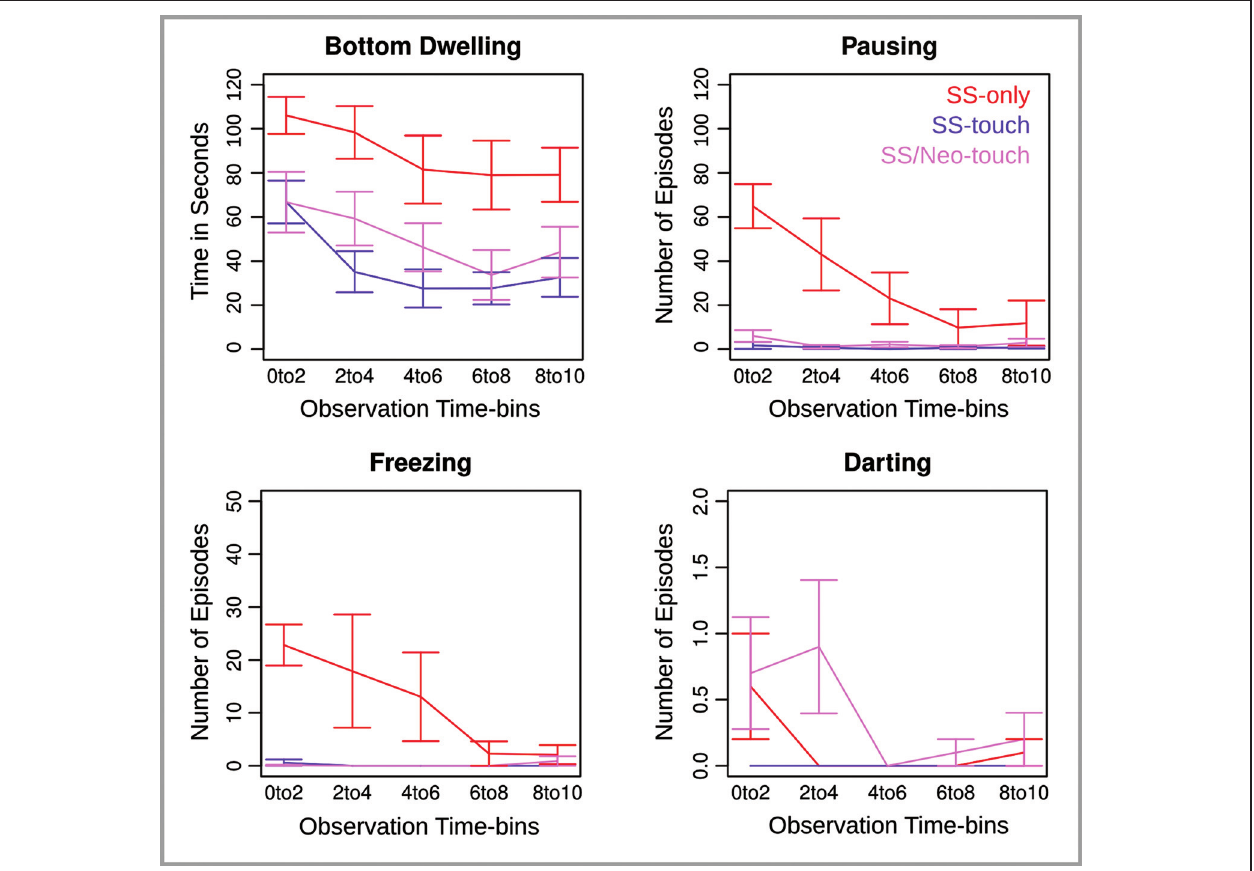
FIGURE 4 | Behavioral measures for Experiment 2 across five consecutive 2 min observation time bins . Error bars reflect the standard error of the mean.